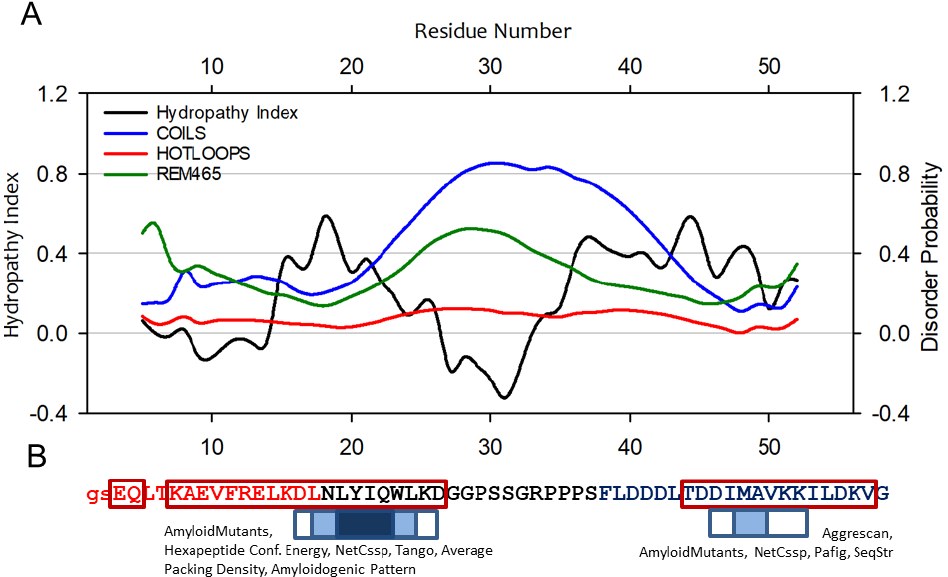
Figure 2. A-Cage-C and some of its predicted properties. ( A ) The Hydropathy Index and disorder probability of A-Cage-C. Hydropathy Index was calculated using the approach of Tanford et al. [37], and plotted over a moving average of 9 amino acids. Disorder was predicted using the DisEMBL server [39], which provide three outputs COILS; HOTLOOPS and REMARK465. ( B ) The sequences highlighted in red and blue corresponds to the membrane binding segments Helix A and C of BLA, respectively. The sequences in black correspond to the spacer segment based on the Trp-Cage fold. The amino acids within dark red boxes are predicted to be helical using PSIPRED [38]. The two lower- case amino acids at the N-terminal are left after TEV cleavage during purification. The sequence is also annotated with in silico-prediction of amyloid-forming tendencies using AMYLPRED2. The results shown are based on the consensus of 10 methods that AMYLPRED2 runs and compares, which are listed and referenced in the Materials and Methods section. The boxes above the sequence indicate consensus between at least three methods (box with white fill), at least five methods (box with light blue fill), and consensus in all 10 methods (dark blue fill). The text above each box indicates which individual approaches are involved in giving a consensus based on at least five of the methods